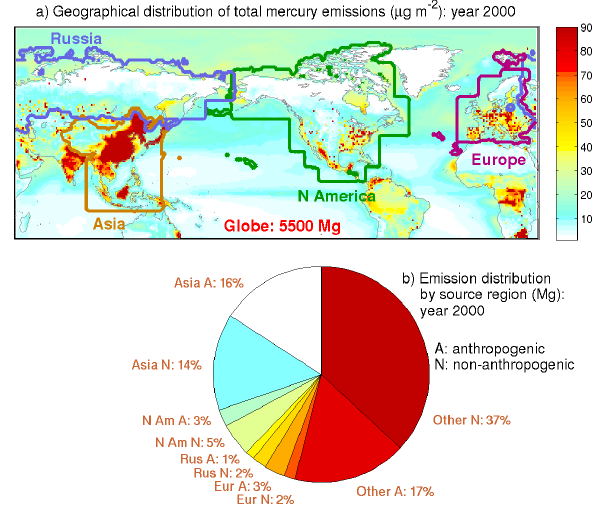
Fig. 2. Total mercury emissions for the study’s four source regions and for the